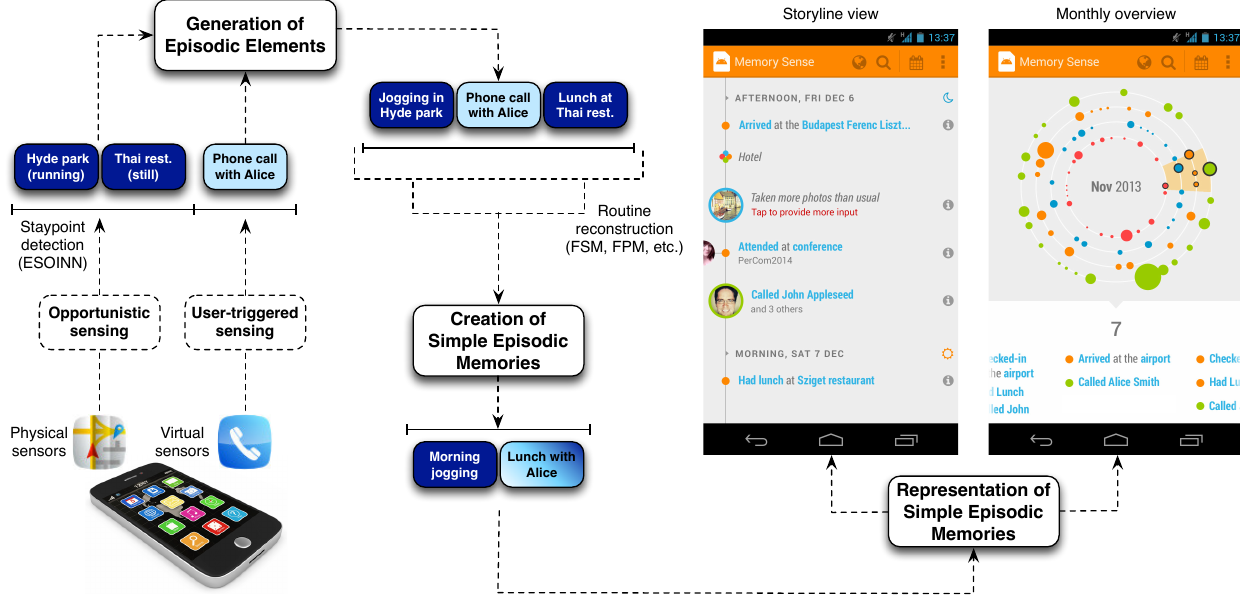
Figure 1: The architectural pipeline of routineSense . First, the Episodic Elements are generated by an algo- rithm for staypoint detection (based on ESOINN), and by the virtual sensors in the phone (e.g., phone calls, SMS, etc.) Then, the routine are reconstructed directly from the Episodic Elements. Finally, our prototype application (embedding routineSense) shows the routines at different granularity levels.